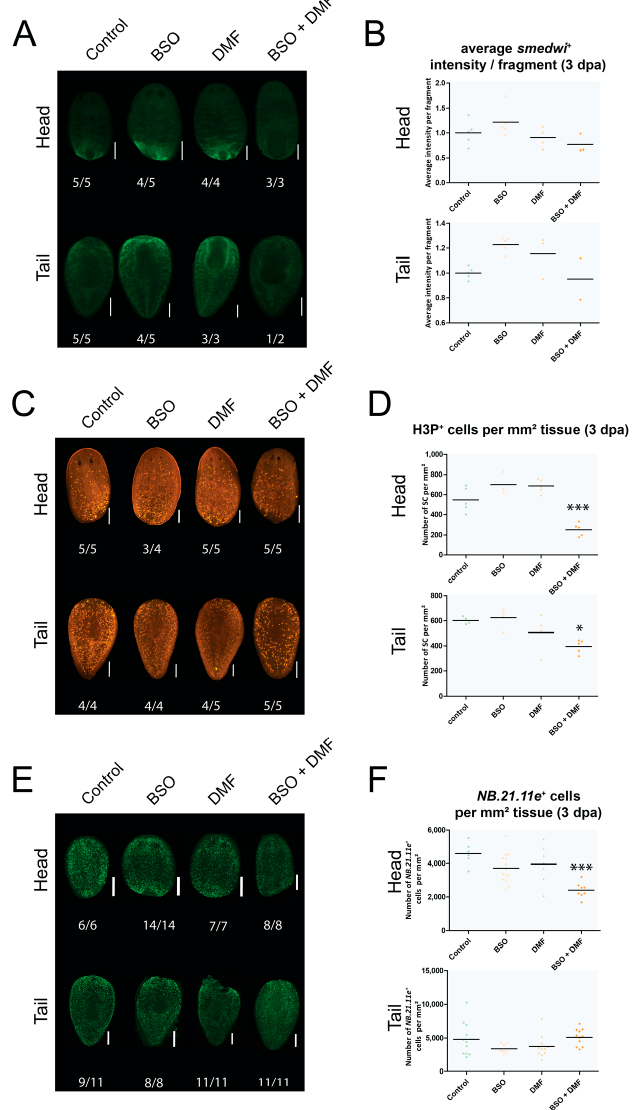
Figure 5. Stem cell responses in 3 dpa head and tail fragments after exposure to compounds that interfere with glutathione content (5 mM BSO, 2.5 µM DMF, pre-exposed for 3 days). ( A ) Smedwi-1 stain as a measure for the total number of stem cells in 3 dpa head and tail fragments. The numbers below the fragments represent how many times the depicted pattern is observed versus the total number of observations. Scale bar represents 500 µm. ( B ) Average intensity of smedwi + signal relative compared with control, 3 dpa (all ns, black line represents average per condition). ( C ) Histon H3P stain as a measure for the number of proliferating stem cells in 3 dpa head and tail fragments. The numbers below the fragments represent how many times the depicted pattern is observed versus the total number of observations. Scale bar represents 500 µm. ( D ) Number of histon H3P + cells, normalised over the surface area of the head or tail fragments, 3 dpa (all compared with control: * p < 0.05, *** p < 0.001, black line represents average per condition). ( E ) NB.21.11e stain as measure for the number of early progeny cells per mm 2 tissue in head and tail fragments, 3 dpa. Scale bar represents 200 µm. ( F ) Number of NB.21.11e + cells per mm 2 tissue in head and tail fragments, 3 dpa (compared with control: *** p < 0.001, black line represents average per condition). (BSO: buthionine sulphoximine, DMF: dimethyl fumarate, dpa: days post amputation, ns: not significant, SC: stem cells).